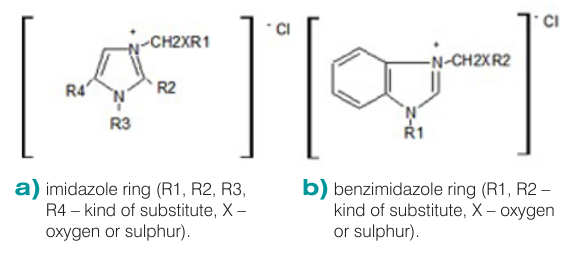
Figure 1. The general chemical structure of imidazole